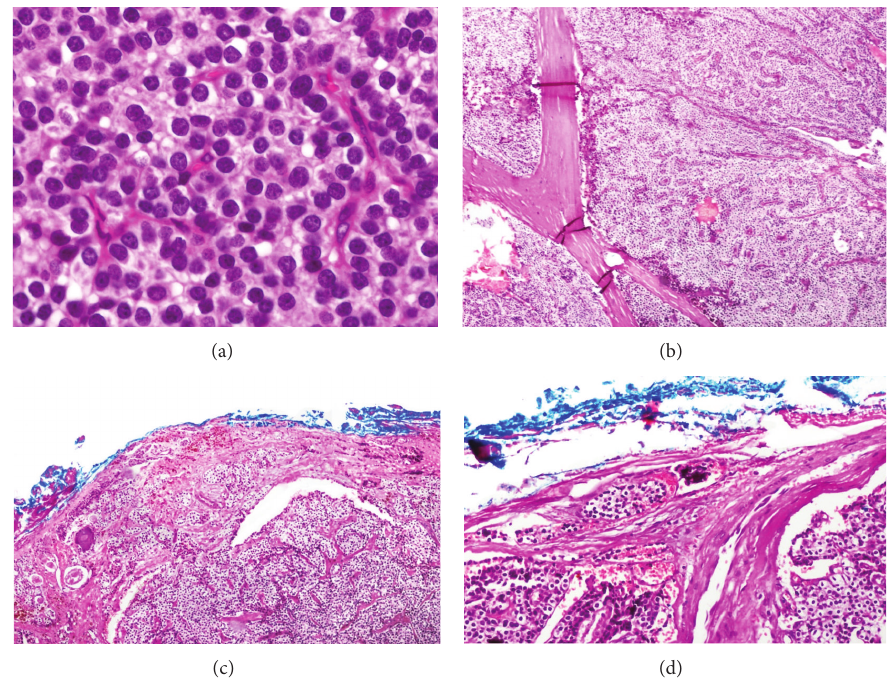
Figure 5: (a) Sheets of polygonal cells with clear cytoplasm and monotonous nuclei without atypia, H&E stain, × 400. (b) Thick fibrous bands, H&E stain, × 50. (c) Focal capsular invasion without perforation, H&E stain, × 50. (d) Vascular invasion, H&E stain, ×